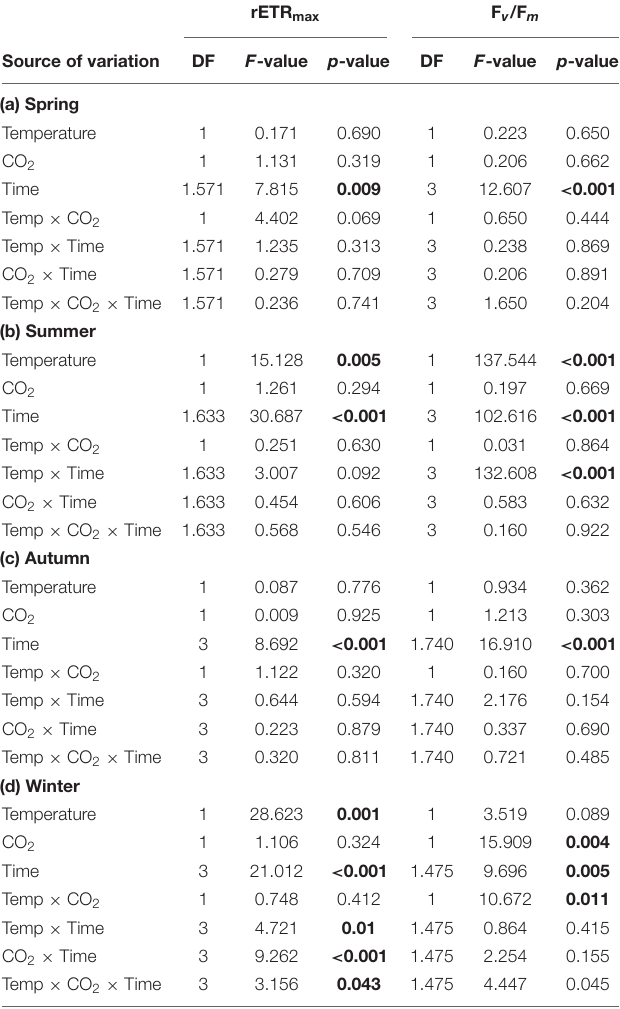
Bold type indicates p-values < 0.05.